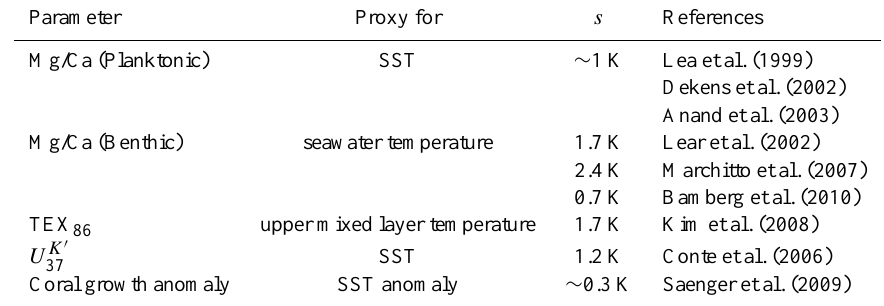
Table 1. Collection of the seawater temperature proxies discussed in this work and their standard errors of estimation ( s